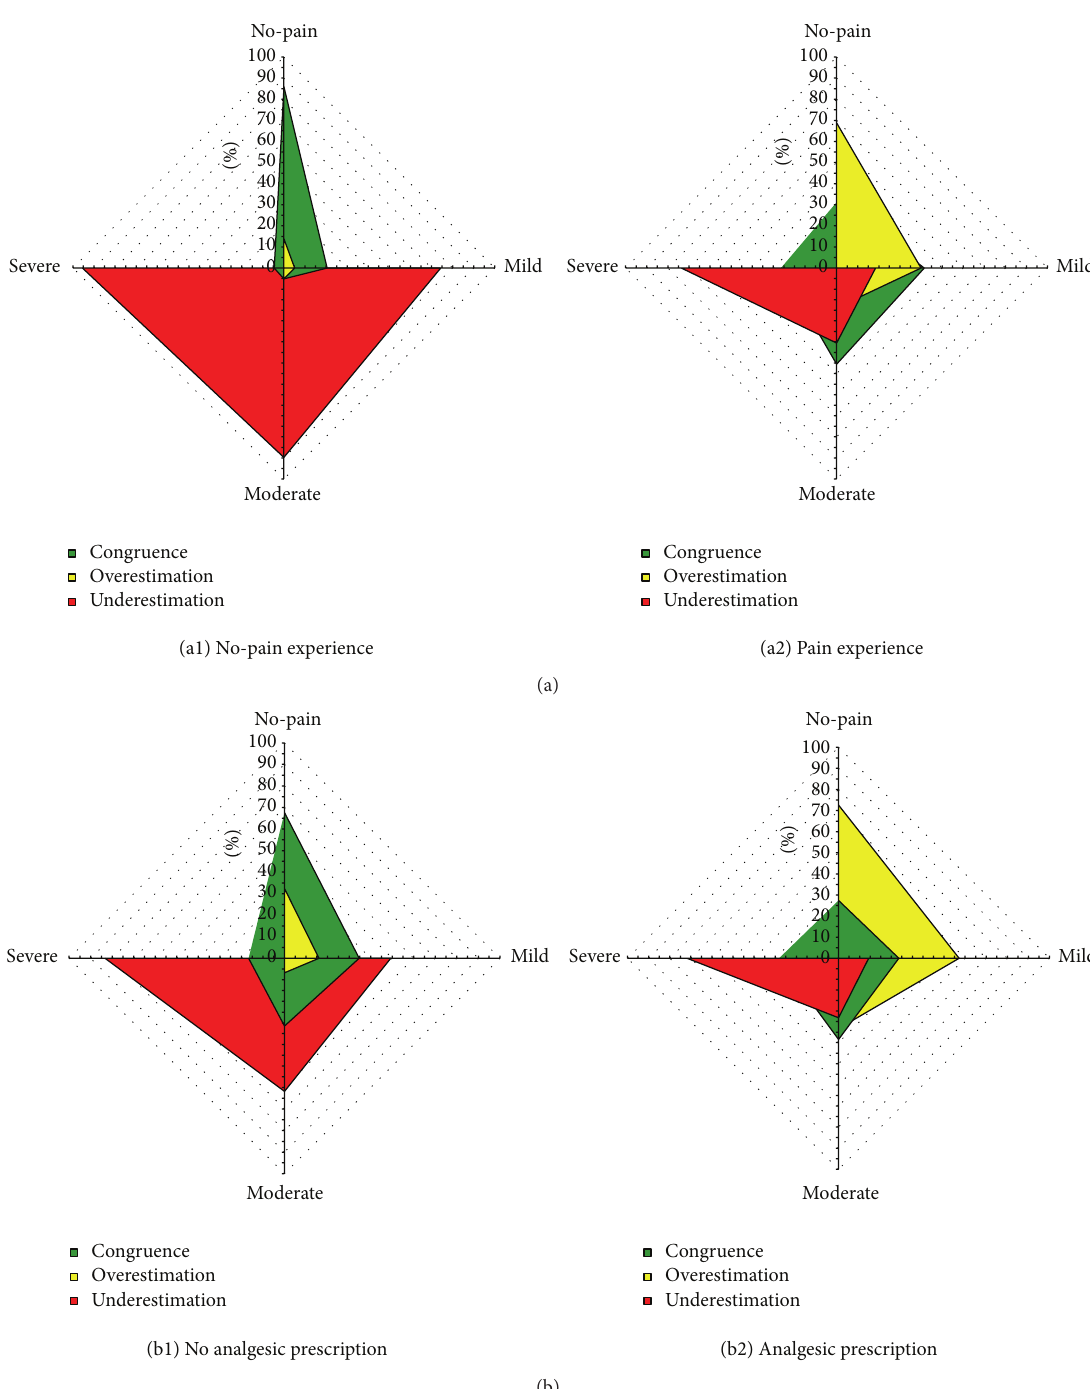
Figure 1: Radar plots of CCs proportions in each PSRP category within the subsets of patients with and without pain experience (a) and within the subsets of patients with and without analgesic prescription